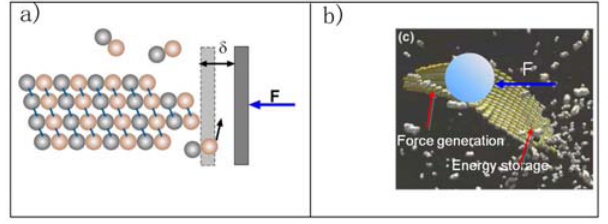
Figure 8. Schematic illustration of force generation models. (a) the ratchet model based on the dimer direct-addition model and (b) the possible force generation mechanisms for the new model.